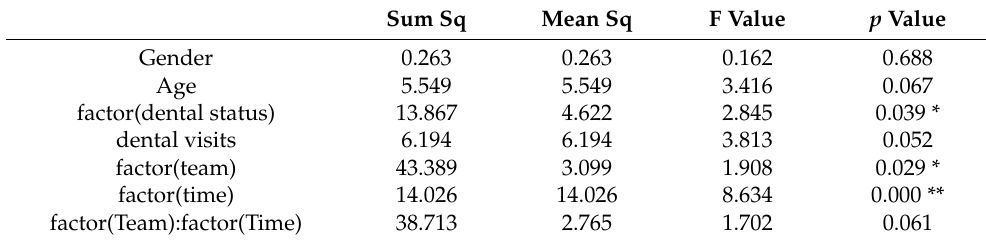
Table 3. Results of the variance F-test.